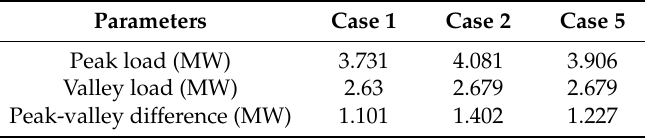
Figure 12. Daily load curve of the distribution network. Table 9. Peak and valley load values in different